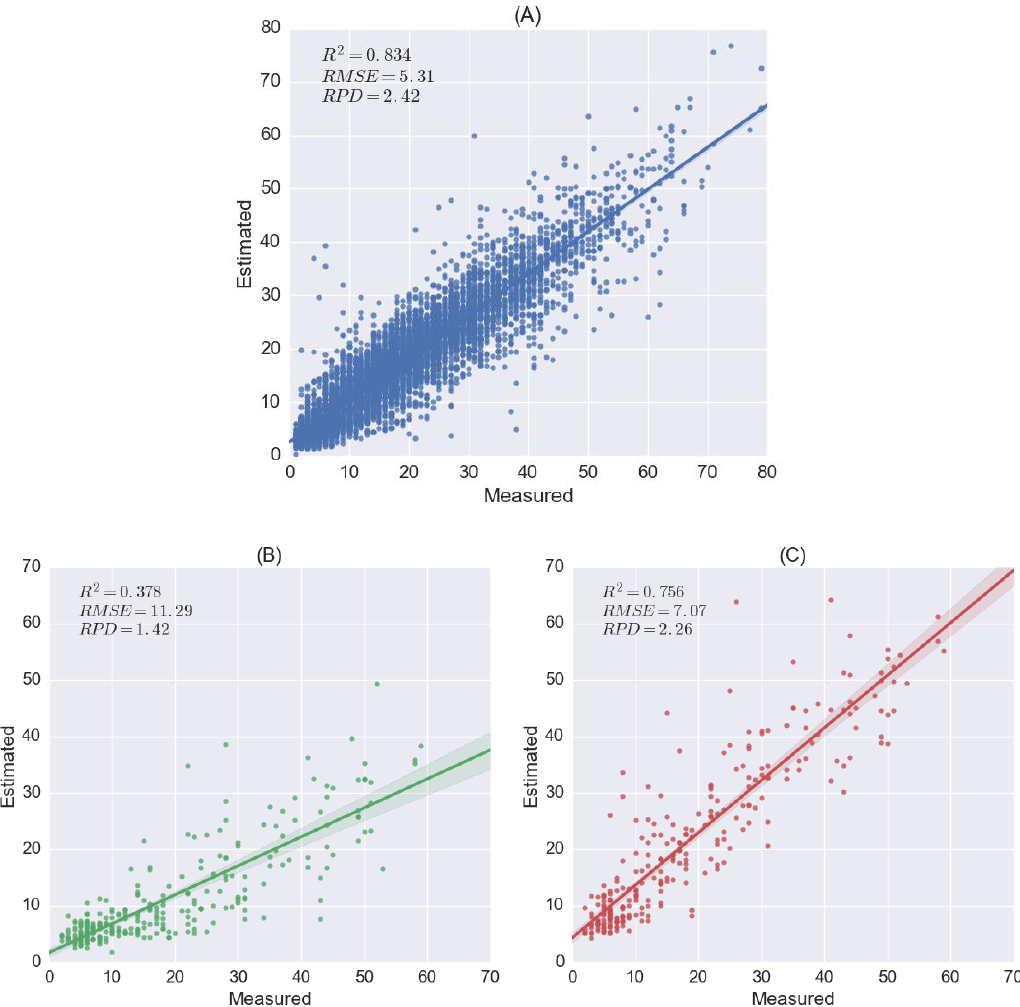
Figure 6. Results of soil clay content estimation for LUCAS mineral and organic soils using one-dimensional convolutional neural network (1D-CNN) and transfer learning. ( A ) The scatter plot of measured and estimated clay content for mineral soils obtained by 1D-CNN model. ( B ) Organic soils using the pre-trained 1D-CNN model developed by mineral soils without fine-tuning. ( C ) Organic soils by fine-tuning the pre-trained 1D-CNN model.